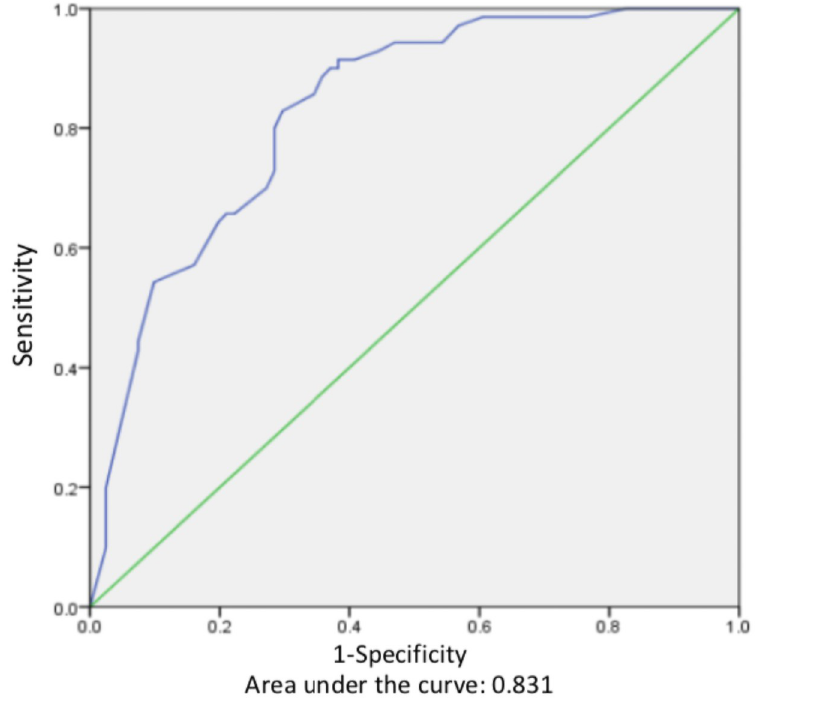
Fig 1. ROC curve of the presence of BLV model predictive of breast